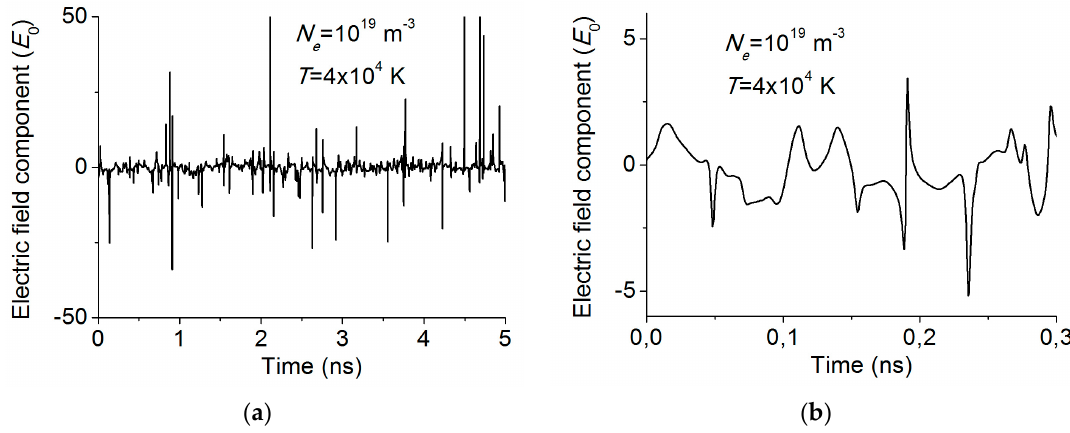
Figure 1. Electric field component in units of E 0 in a plasma with a density N e = 10 19 m − 3 , and a temperature T = 40,000 K, during ( a ) a time interval of the order of the time of interest for the L α line, and ( b ) a time interval of the order of the time of interest for the H β line.